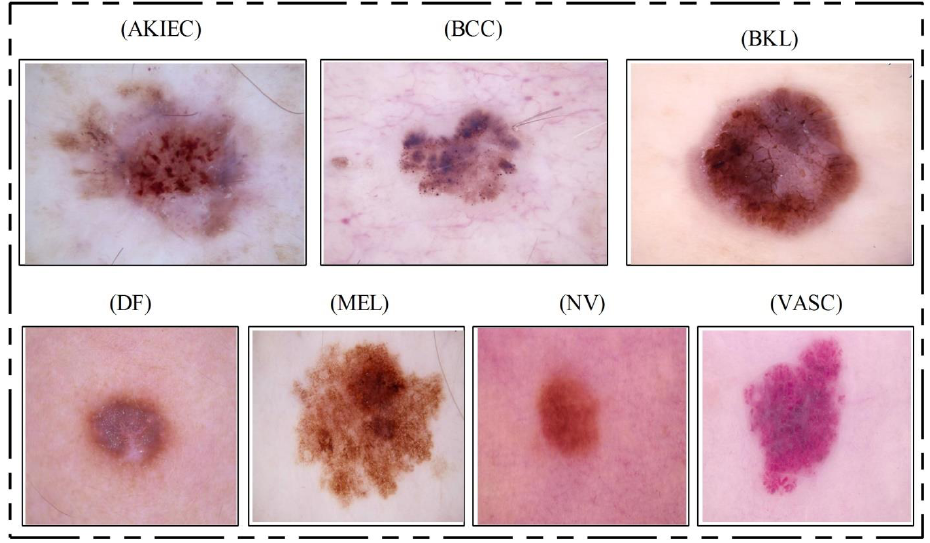
Figure 4. Sample skin lesion types collected from the HAM10000 dataset [23].